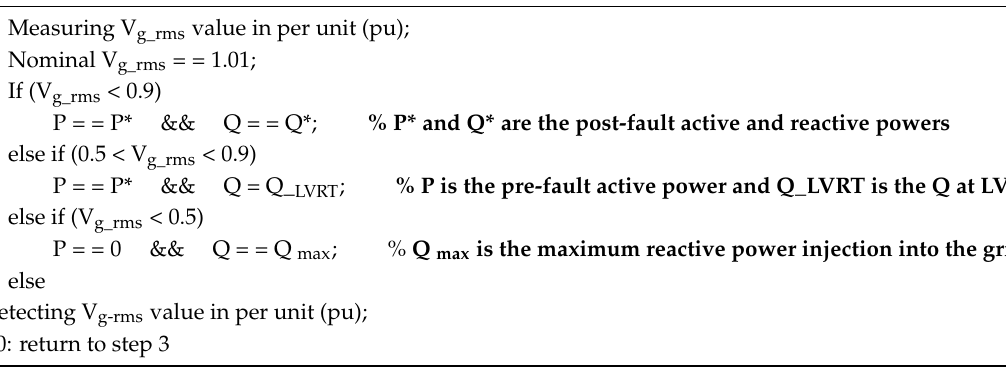
Algorithm 1 : Proposed LVRT method based on reactive power injection.